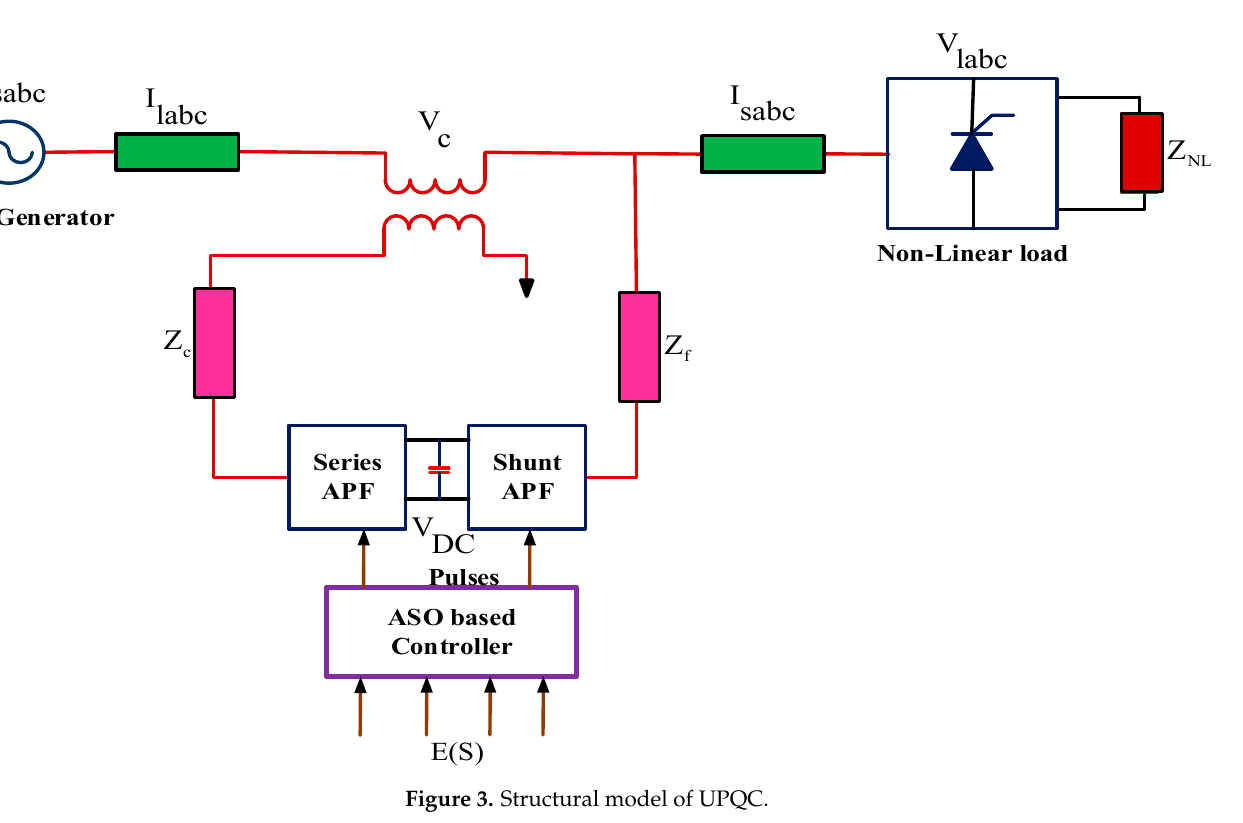
Figure 3. Structural model of UPQC.